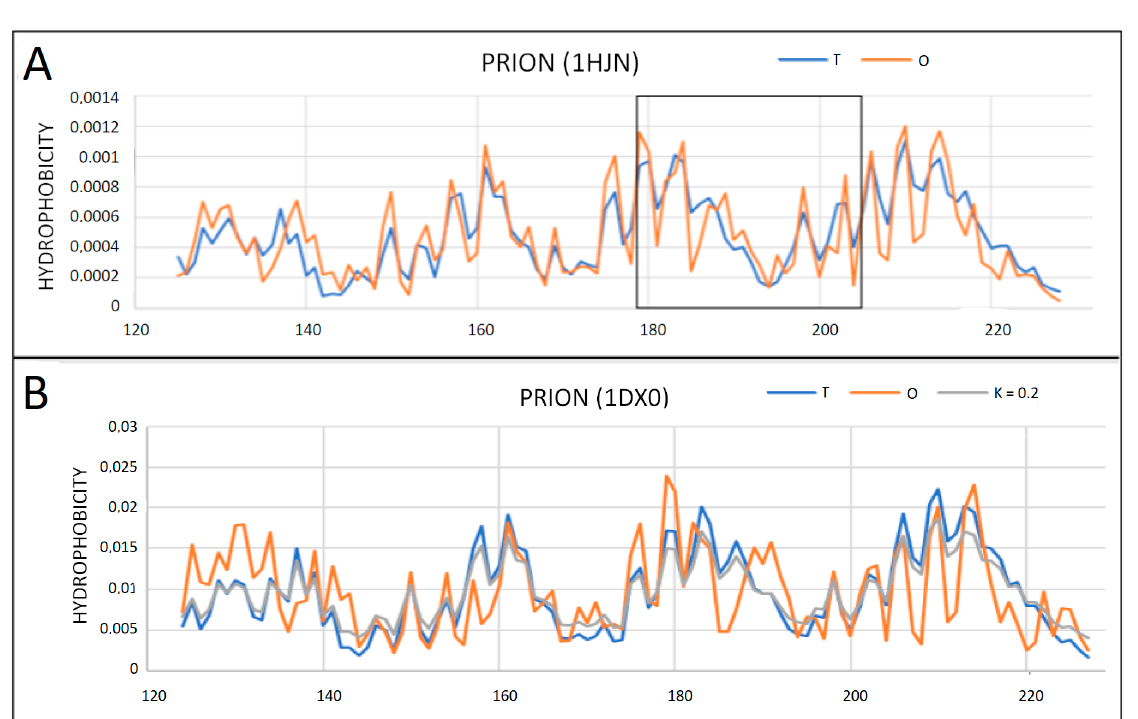
Figure 4. Profiles T, O and M for single-chain prion proteins. ( A ) 1HJN—the section delimited by the disulfide bond is marked with a frame (K = 0 for this distribution); ( B ) 1DX0—the M distribution showing a slight modification of the T distribution is also placed.